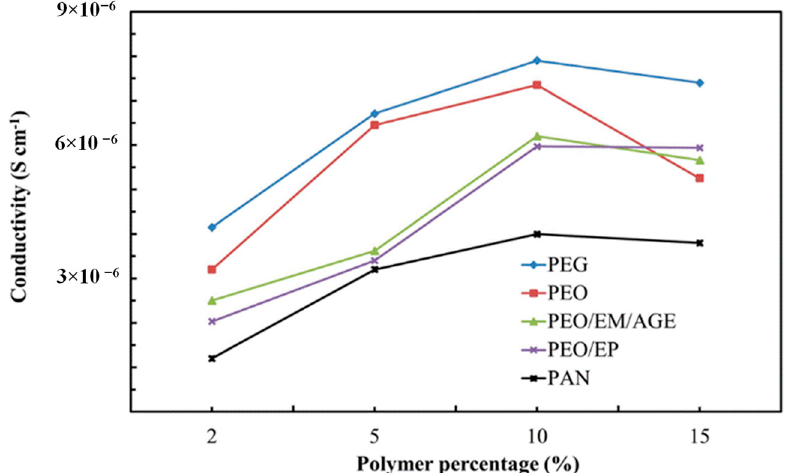
Figure 6. Ionic conductivity of composites with different polymers.